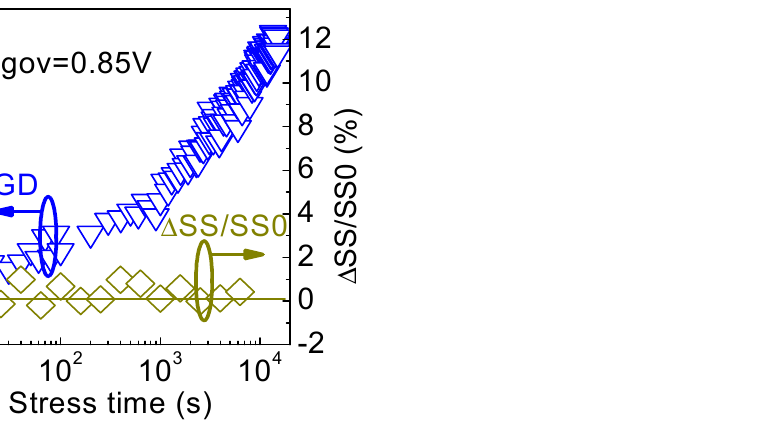
Figure 35. Under positive gate bias, generated defects (GDs) increased, but the negligible change in subthreshold swing (SS) indicates that interface states were not created [39].